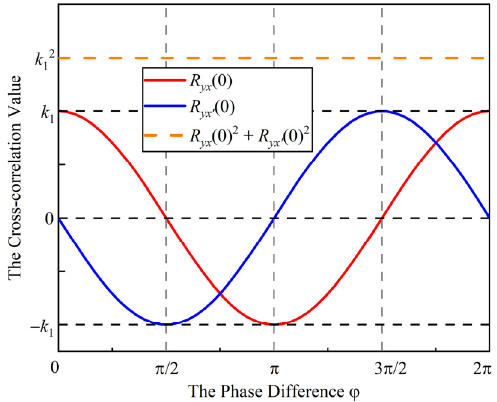
Figure 10. The power consumption of the proposed cross-correlation AFE.